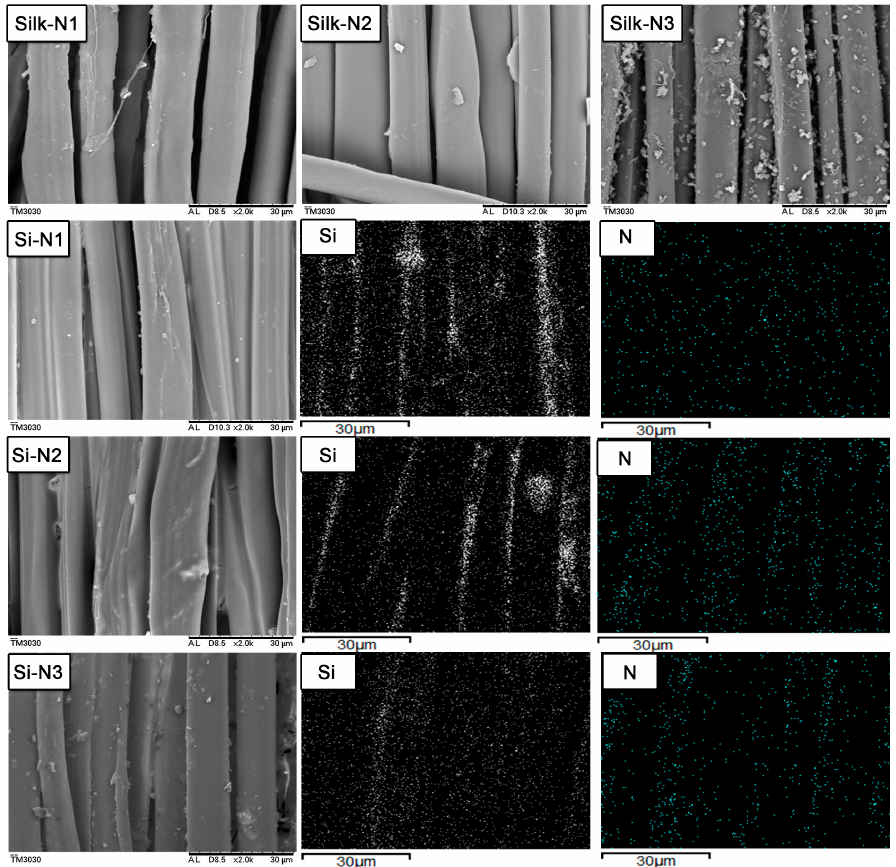
Figure 2. SEM magnifications of Silk-N 1 , Silk-N 2 and Silk-N 3 , Si-N 1 and Si-N 2 , Si-N 3 samples and elemental analysis of Si-N 1 , Si-N 2 and Si-N 3 samples. Materials 2018 , 11 , x FOR PEER REVIEW